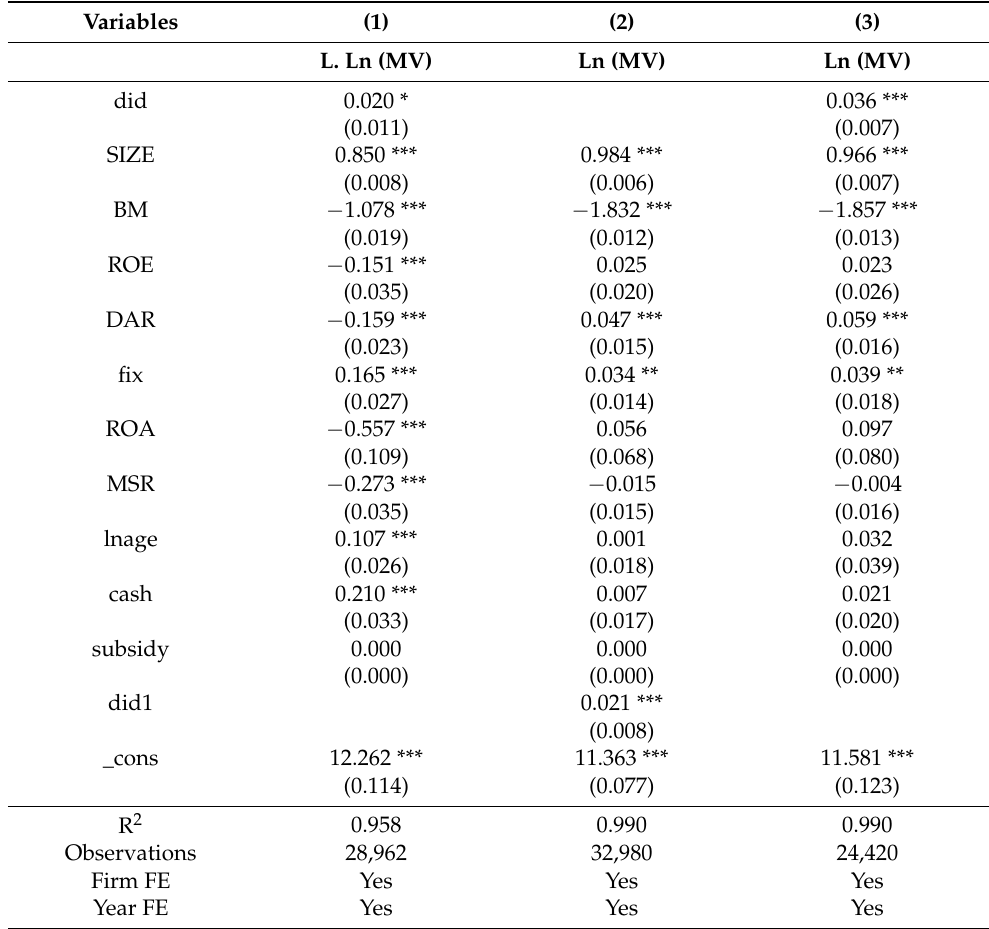
Table 5. Regression results of the other robustness